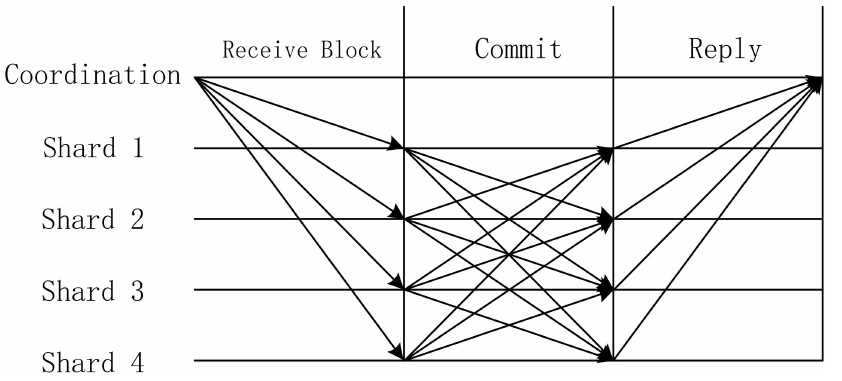
Figure 8. The process of verifying the